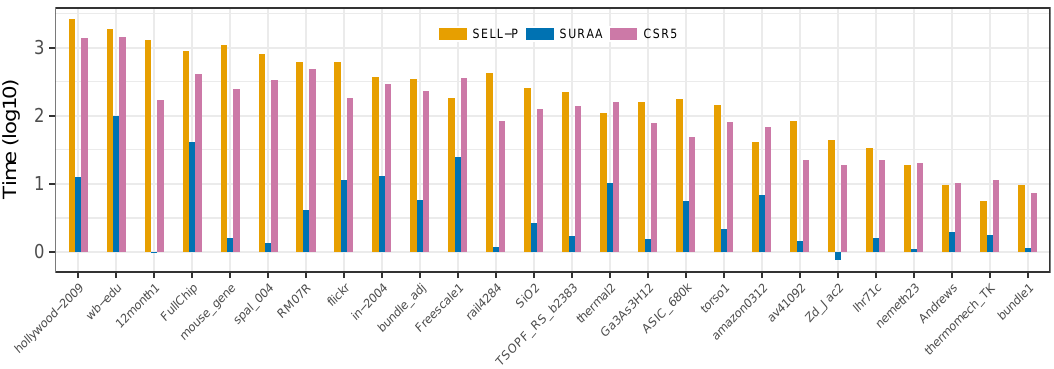
Figure 14. SURAA: Effective format conversion cost comparison with CSR-5 and SELL-P.